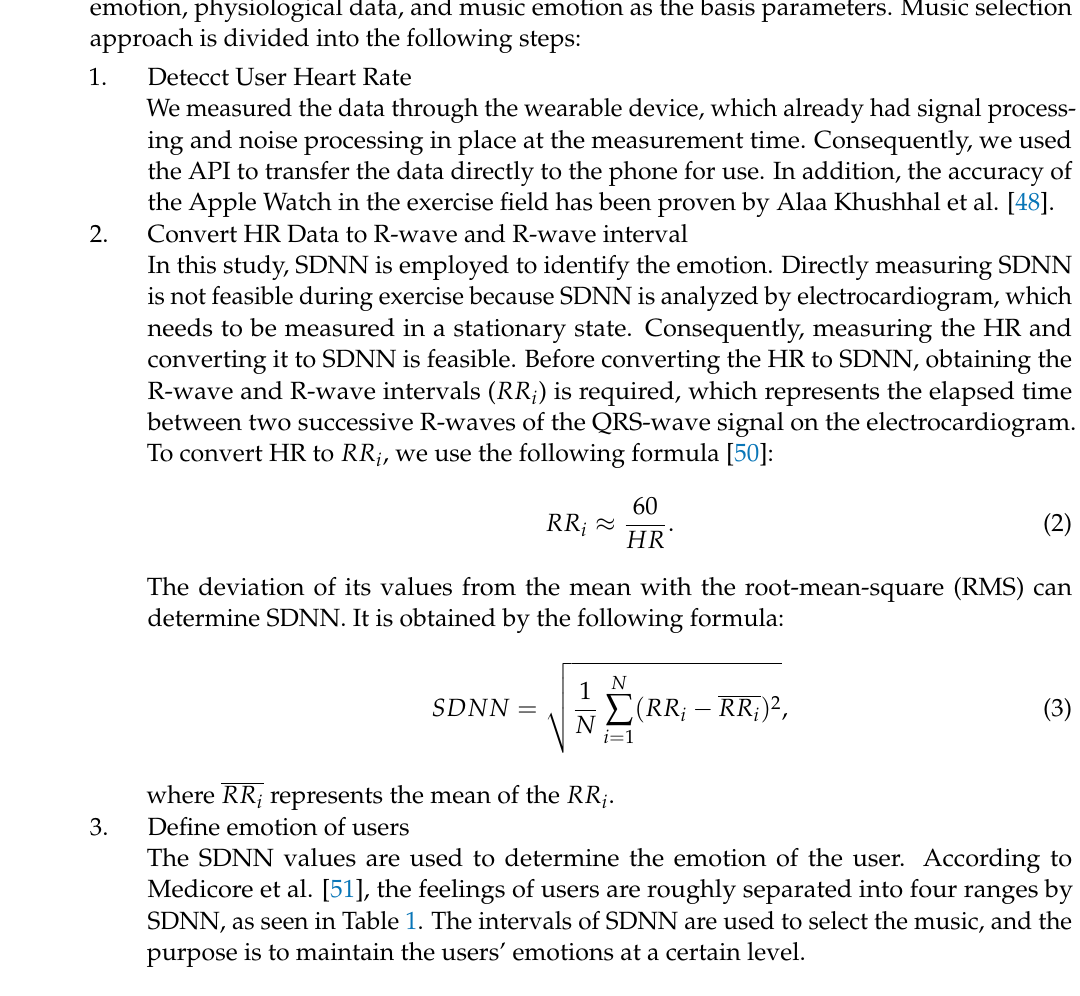
Table 1. Emotion